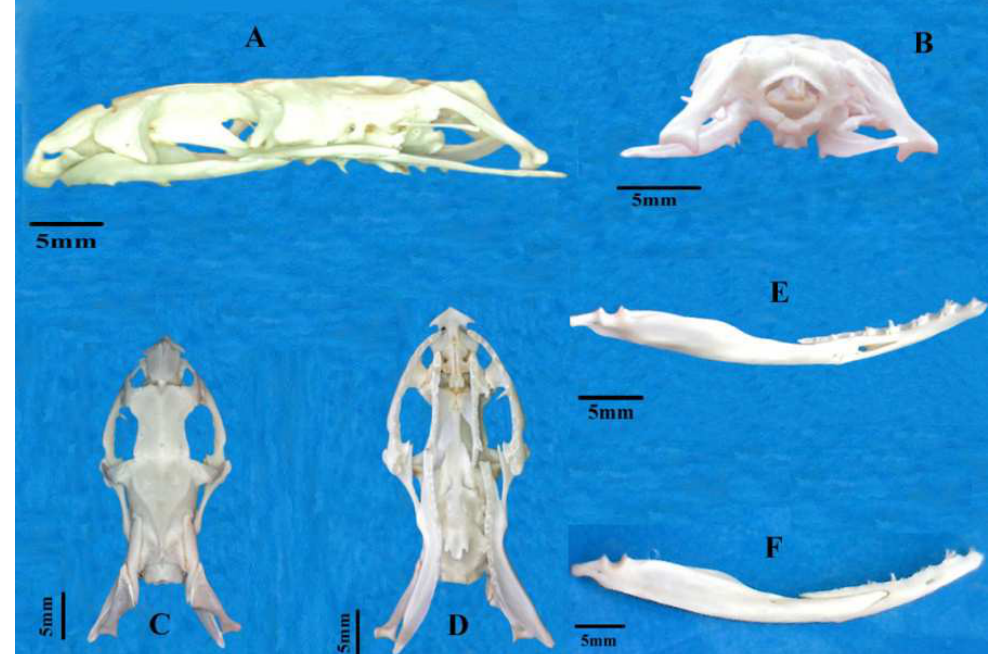
F IGURE 2. Dolichophis jugularis skull. Lateral view (A); posterior view (B); dorsal view (C); ventral view (D); ventral view of lower jaw (E); dorsal view of lower jaw